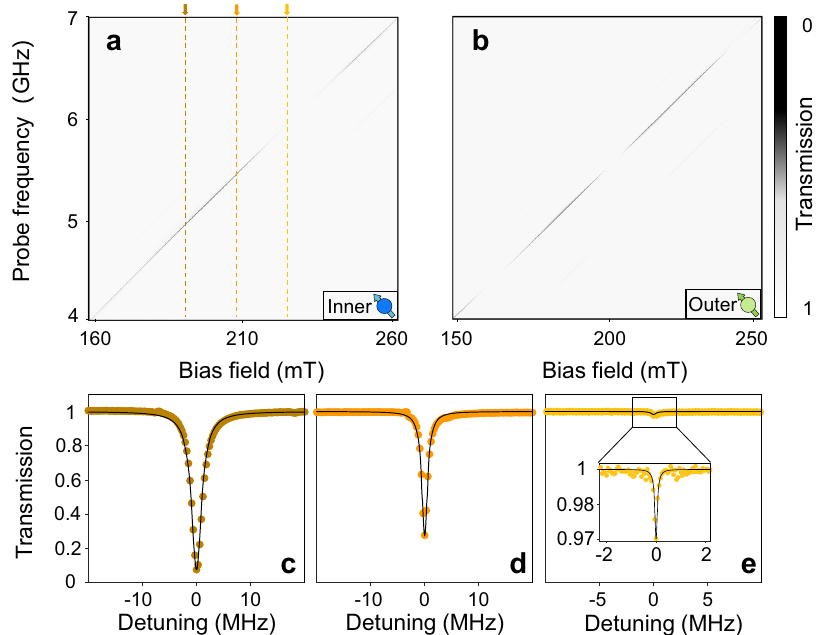
c – e Threetypicalspectraextractedfrom a .Thedotsareexperimentaldataandthe black solid curves are theoretical fi